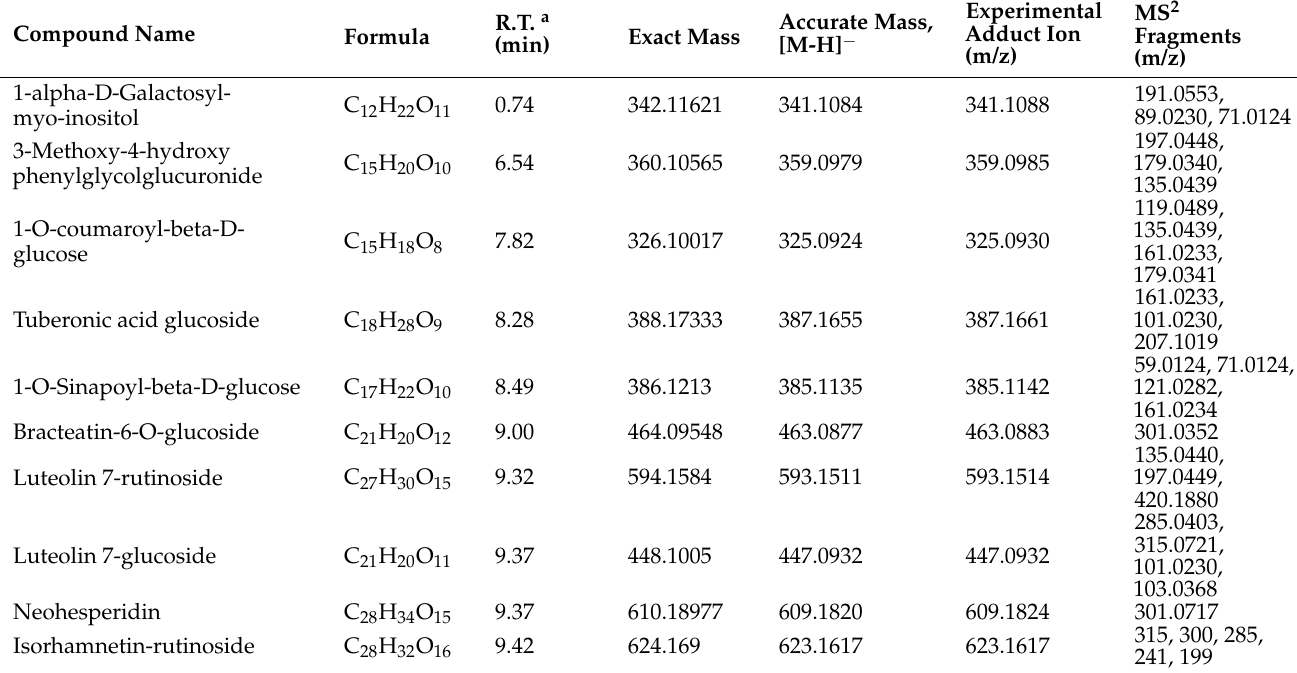
Table 3. The chemical compounds identified in the R. officinalis extract by UHPLC-Q-Exactive high- accuracy analysis of deprotonated precursors and fragment ions of specific components combined with data processing using Compound Discoverer